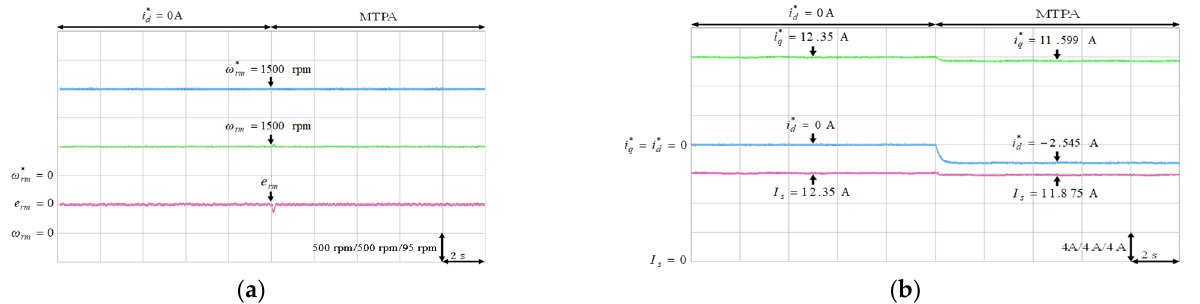
Figure 14. Experimental results of MTPA control at 1500 rpm with 9 Nm: ( a ) mechanical speed command, speed and speed error; ( b ) q -axis current command, d -axis current command and stator current.